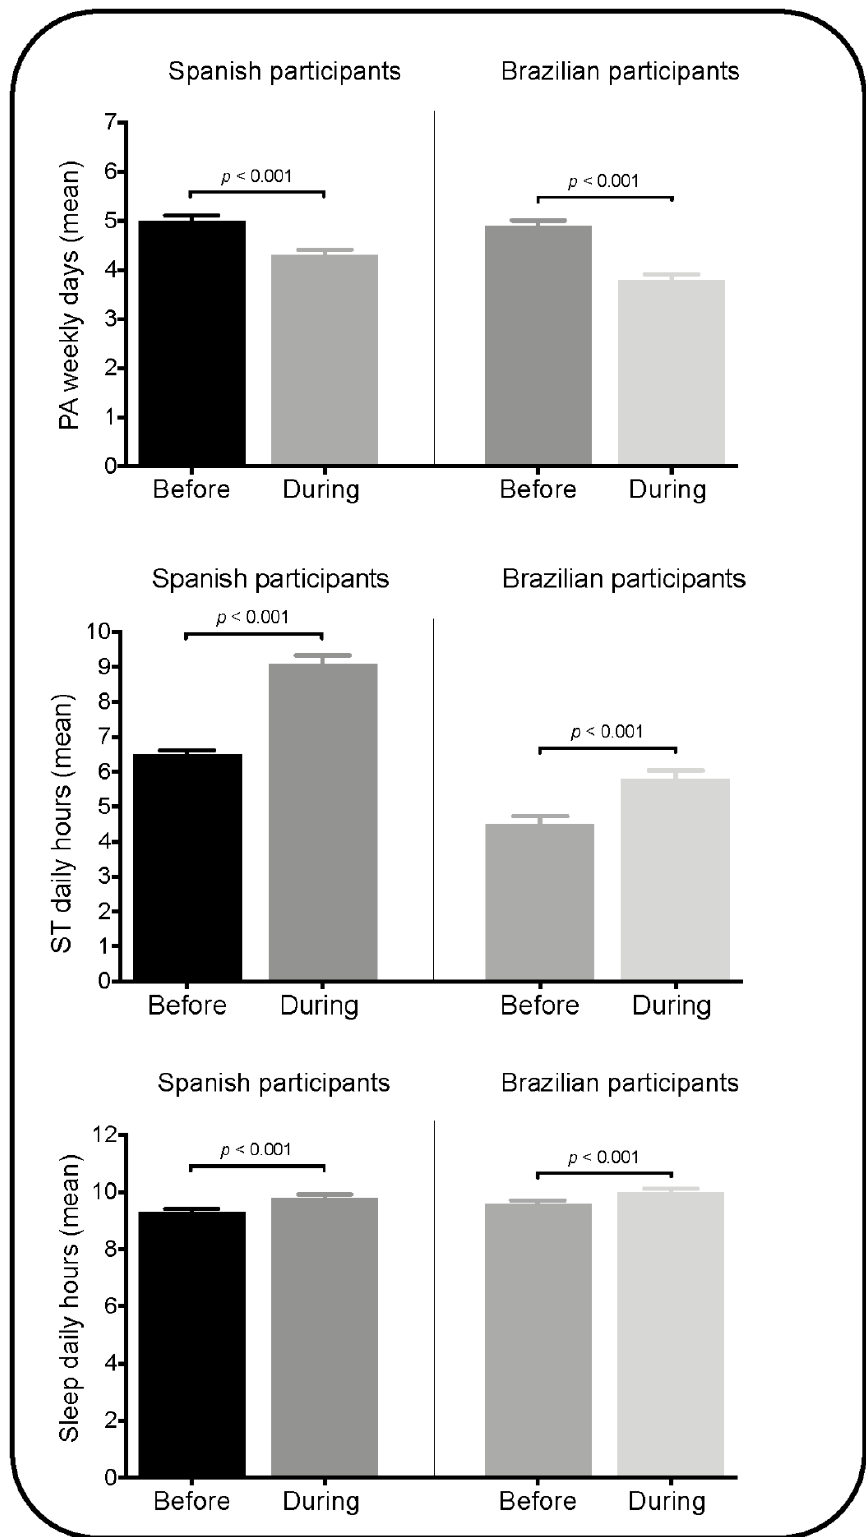
Figure 1. Changes in parental-reported physical activity (PA), screen time (ST) and sleep duration during the COVID-19 lockdown according to the country. Data expressed as mean (SEM).